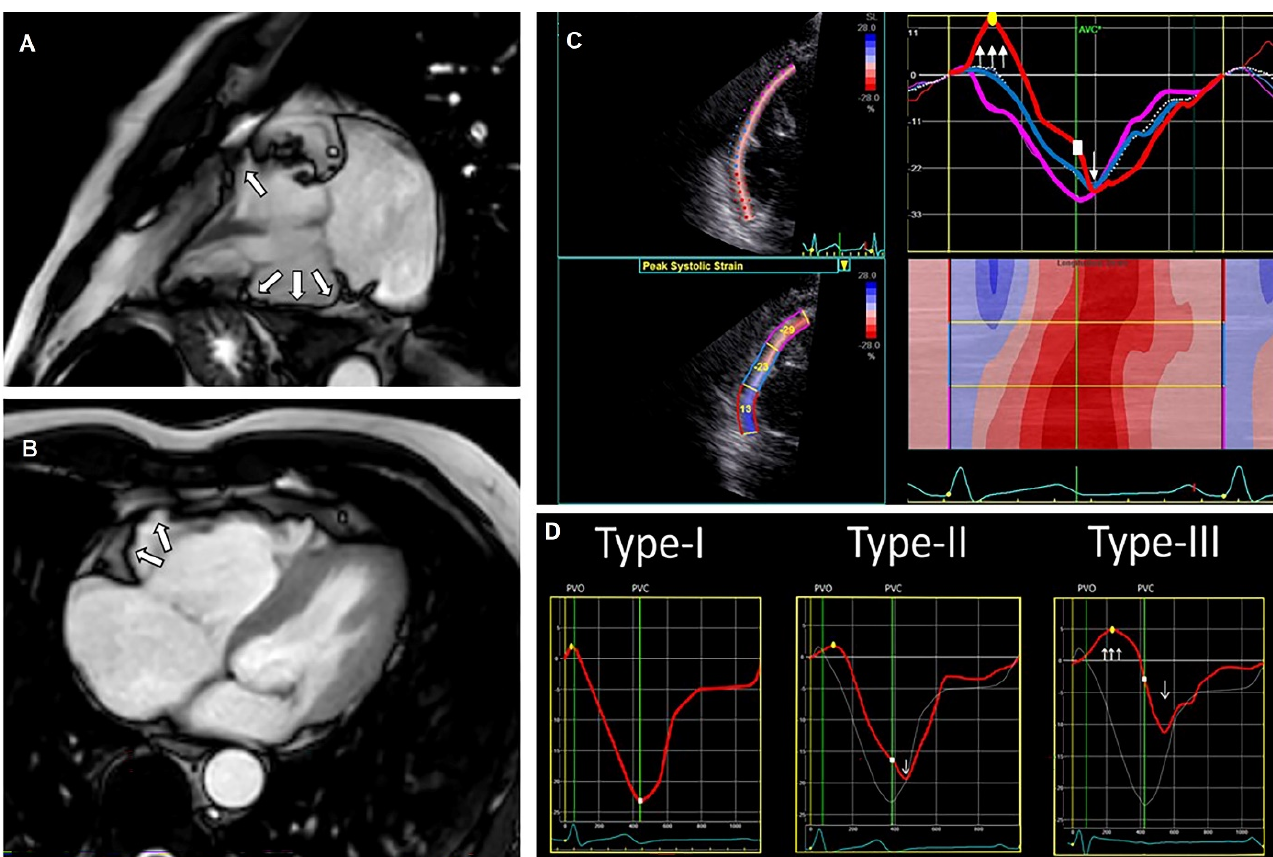
Figure 4. Cardiac magnetic resonance (CMR) images from a patient with arrhythmogenic cardiomyopathy (ACM), including a typical echocardiographic deformation imaging pattern. CMR images ( A , B ) with right ventricular (RV) aneurysm (white arrows). Echocardiographic deformation imaging ( C ) with RV focused and peak systolic strain measurements and deformation pattern. Dis- tinct types of RV deformation patterns ( D ) as determined by Mast et al. [47]; type-I: normal